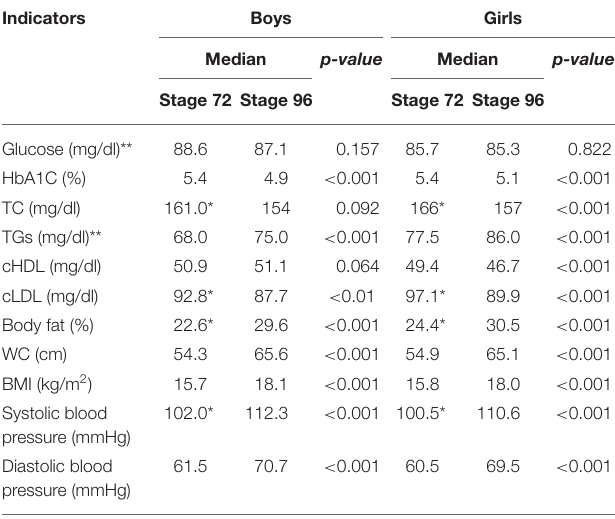
TABLE 3 | Children’s metabolic syndrome risk factors according to the cutoff points by sex and study visit. Indicators Boys